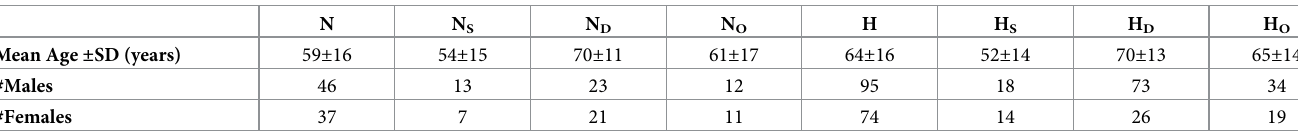
Table 1. Mean age ( ± 1 SD) and gender distribution in the eight subject